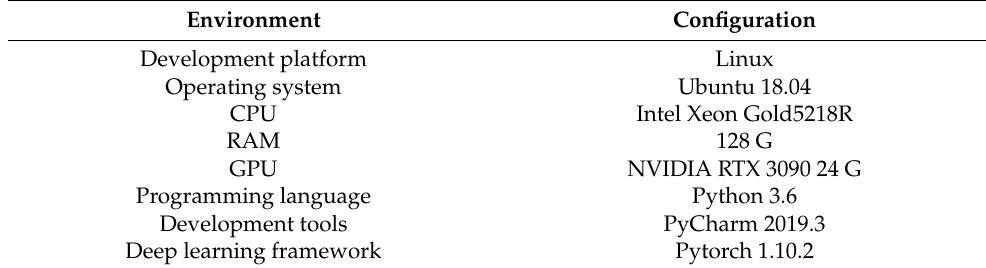
Table 4. Experimental environment configuration